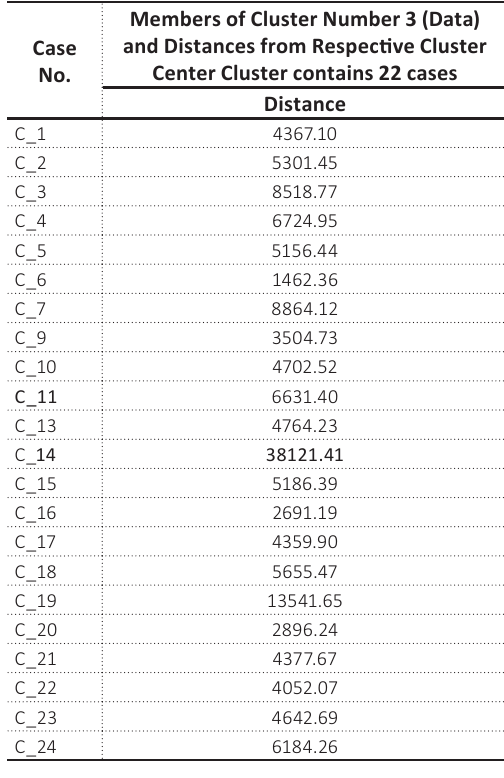
Figure 5. Banks in the third cluster